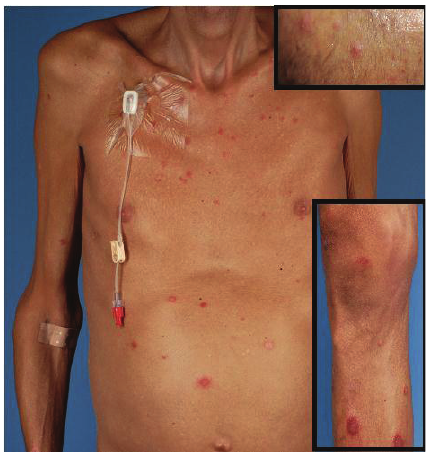
Figure 1: Generalized multiple erythematous, pustular plaques, papules, and nodules preexisting since several years in an HIV- positive patient with cutaneous and visceral L. donovani/infantum complex infection.